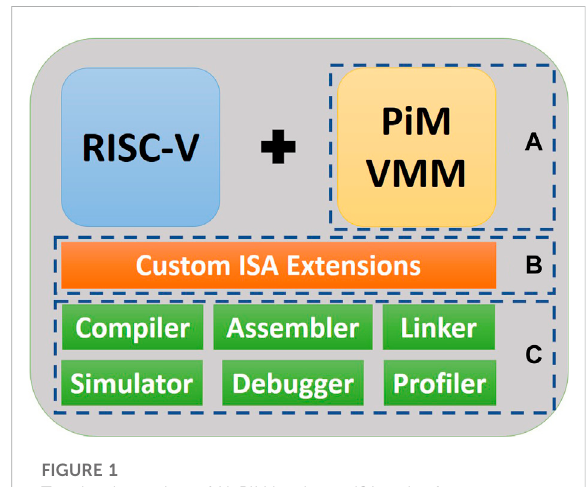
FIGURE 1 Top-level overview ofAI-PiM hardware, ISAand software co- design methodology. (A) RISC-V hardware is extended with the addition of PiM based Vector-Matrix Multiplication (VMM) functional unit. (B) Custom instruction extensions are added to the RISC-V ISA to expose the VMM functionality of the